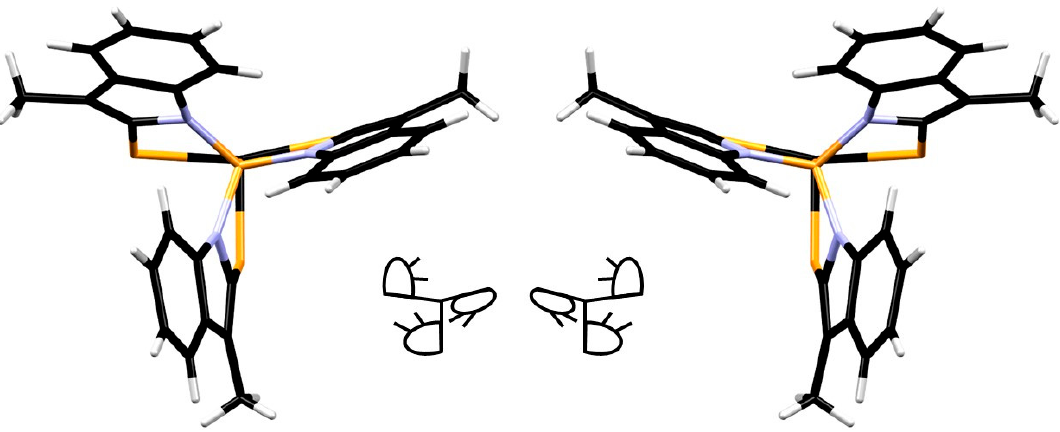
Figure 8. Bottom view of X-ray structure of RuCl 2 L2 H of both rotamers, showing only the (3-methylindolyl)phosphine part. Insert: schematic representation of the two rotamers where the 3-methylindolyl moiety is twisted clockwise ( left ) or counter-clockwise ( right ).